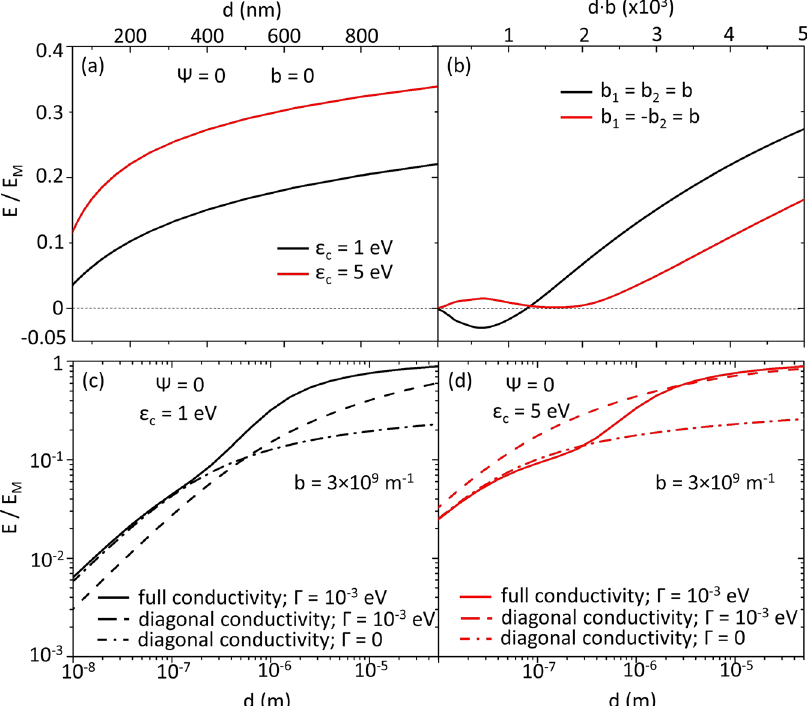
¼ (cid:3) π 2 _ c as a function of: a distance for M 720 d 3